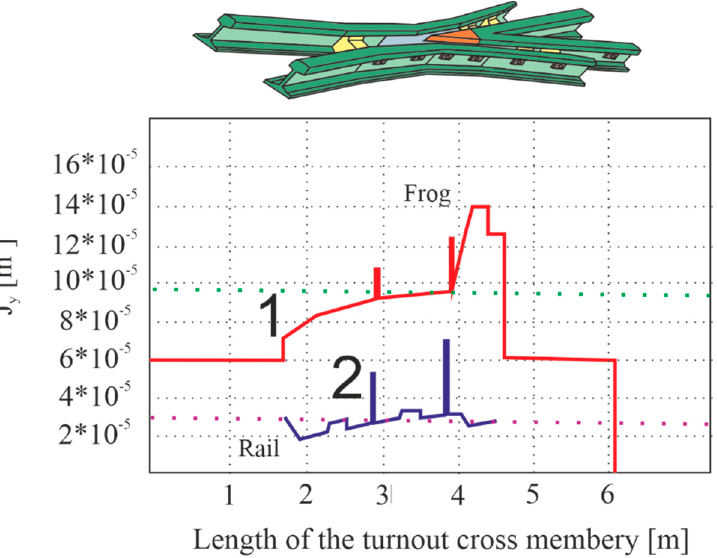
Figure 7. Course of variation of the moment of inertia of a turnout cross member: 1—crossbuck as a monolithic unit J Y = 9.6 · 10 − 5 m 4 , 2—crossbuck bow as an element independent of the wing rails J y = 3.03 · 10 − 5 m 4 [15].